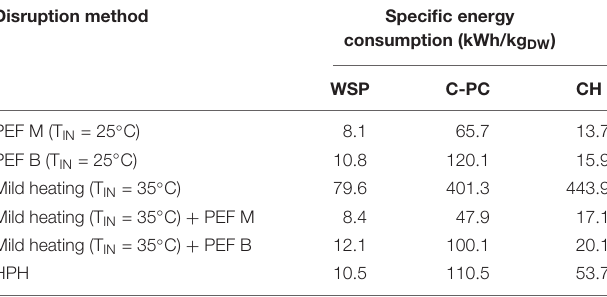
TABLE 1 | Specific energy consumptions (EC, in kWh/kg DW ) of the different cell disruption techniques for the recovery of a unit mass of target compounds